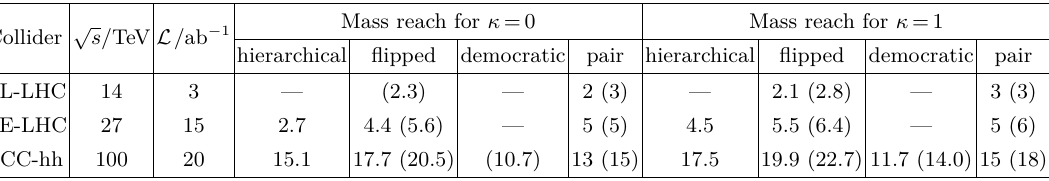
Table 3 . Mass reach in TeV for vector leptoquark single production in the hierarchical, flipped and democratic scenarios from section 2.2 and pair production, at different future colliders for κ = 0 and κ = 1 . For single production we provide the mass reaches corresponding to the upper limit of the cross section band resulting from eqs. (2.10), (2.13). In the flipped and democratic scenarios as well as for pair production we show the increased mass reaches for V 3 in parentheses, for the hierarchical scenario the V 1 , V 3 reaches are the same, see appendix A for